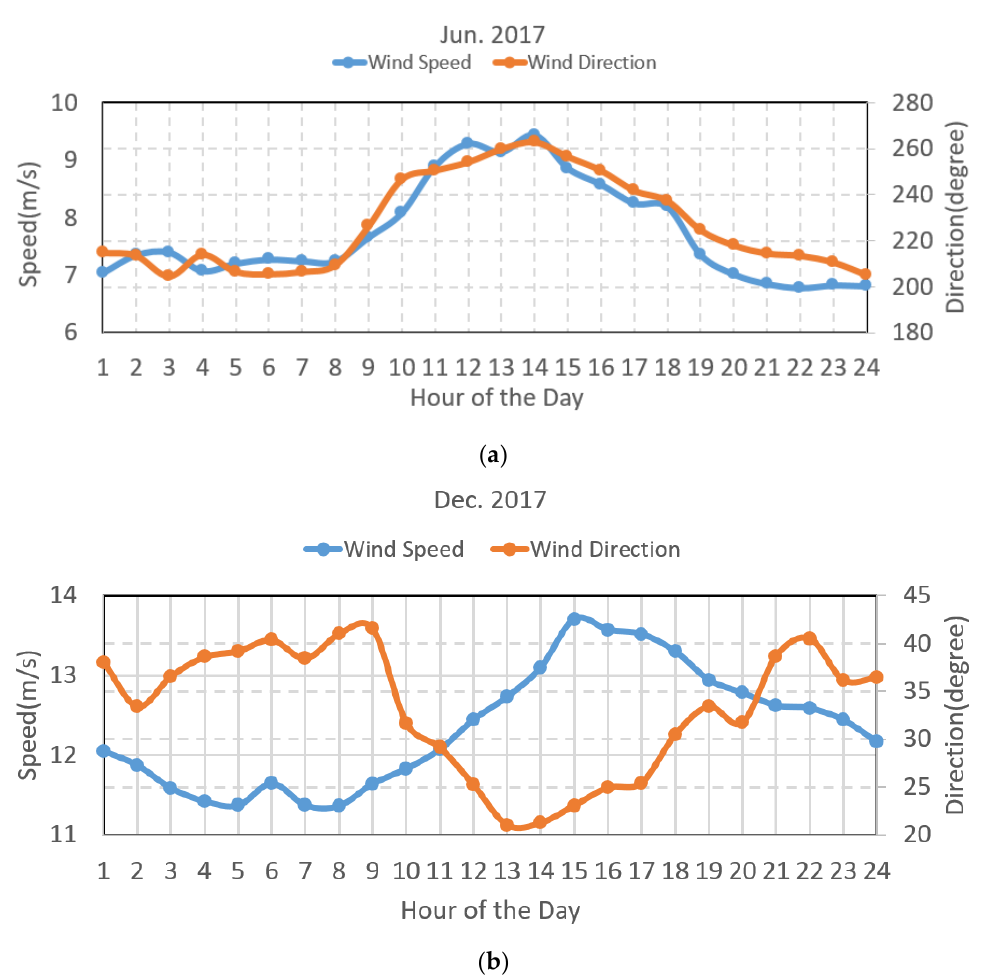
Figure 6. ( a ) Hourly mean wind speed and direction at 90-m height in June 2017. ( b ) Hourly mean wind speed and direction at 90-m height in December 2017.